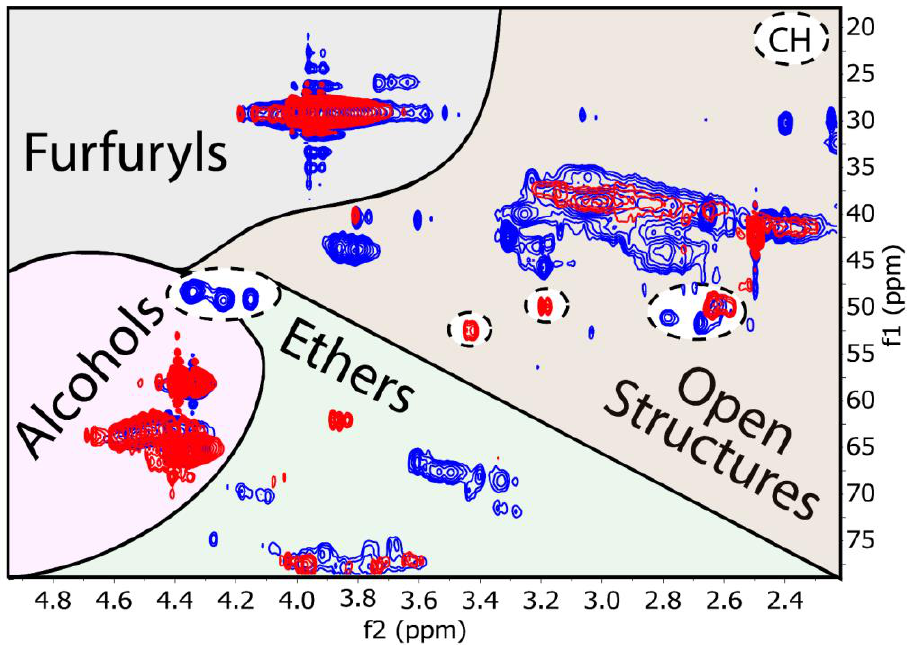
Figure 3. Magnified HSQC spectra of PFA+ (blue) and PFA° (red) of the CH 2 area. The red spectrum is stacked on top of the blue one. The clusters circled in black dashed lines are CH groups.